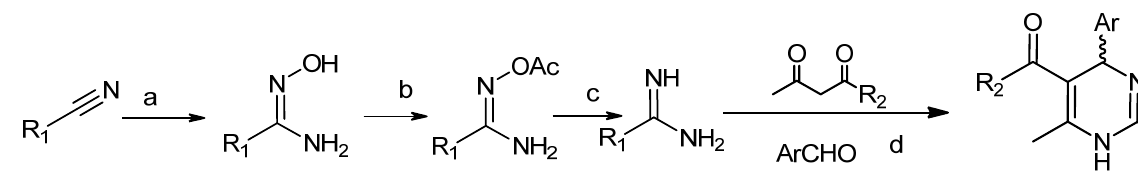
Scheme 1. Synthesis of racemic